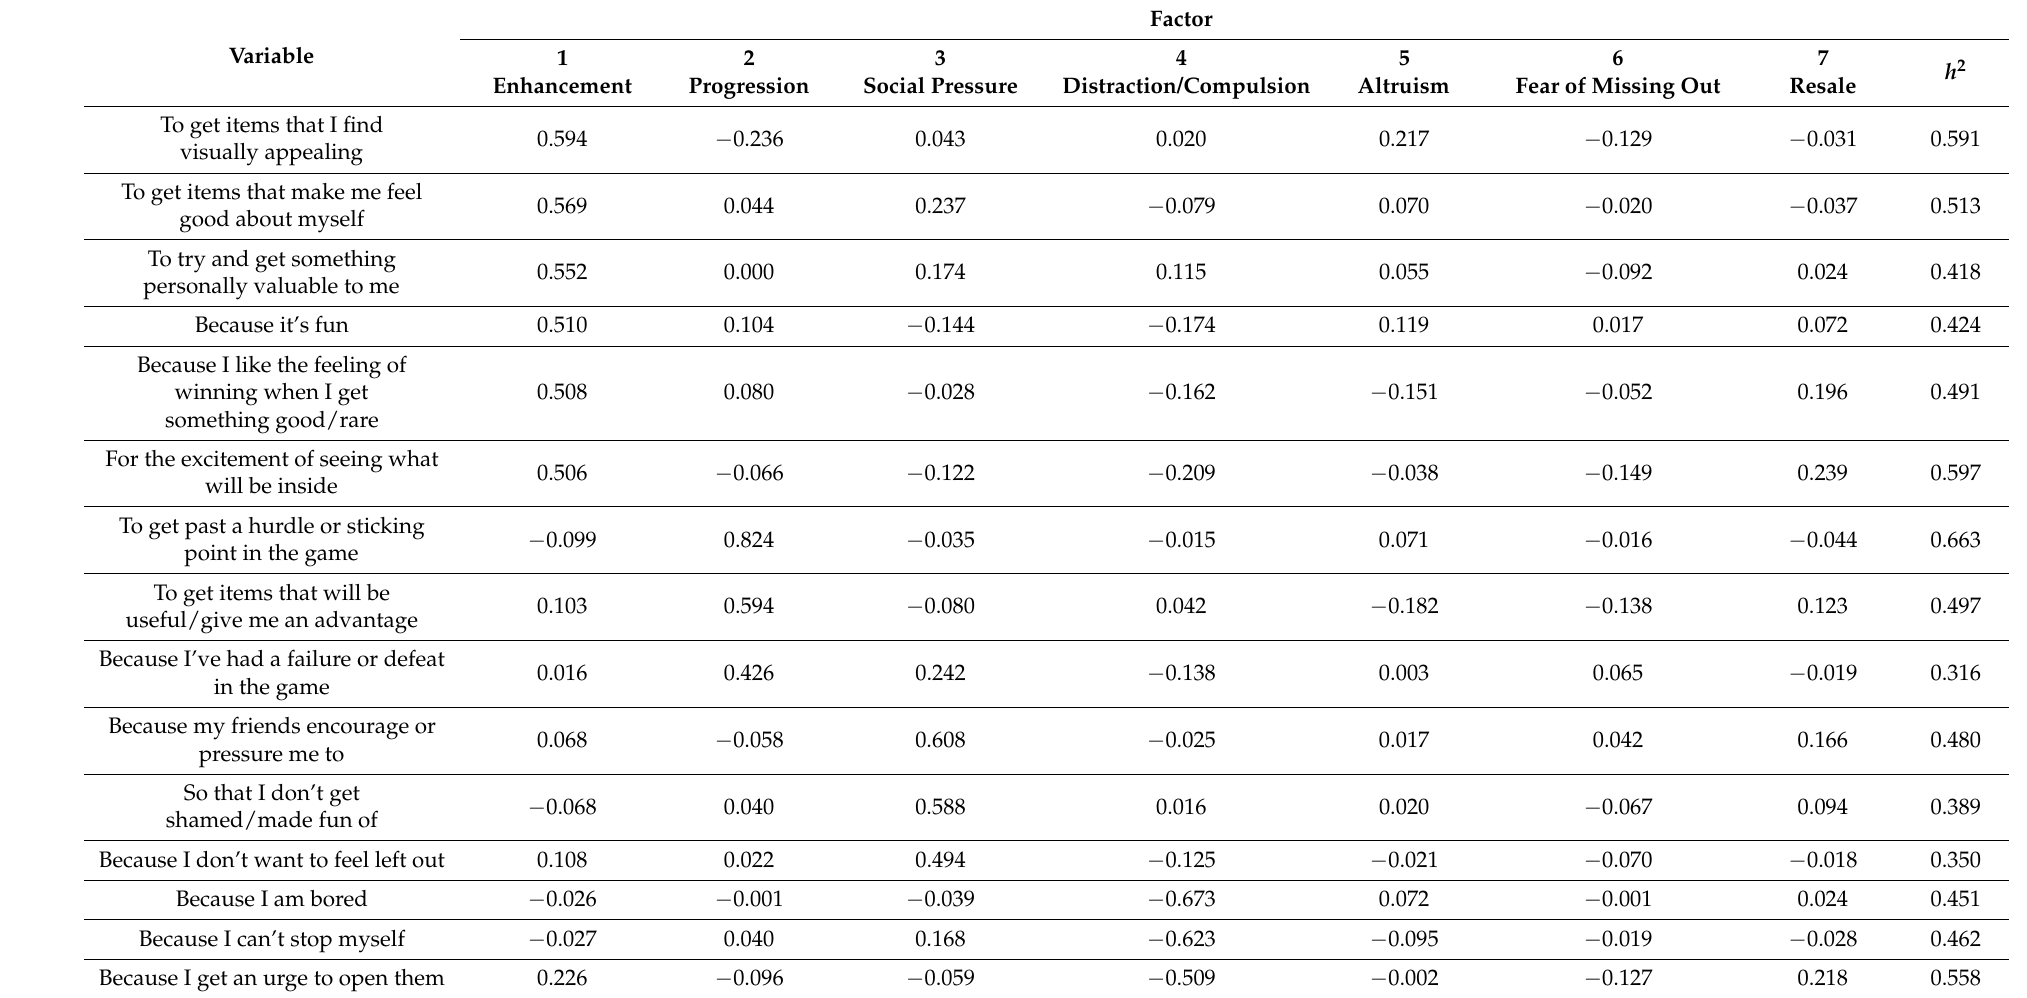
Table 3. Motivation Factor Pattern Matrix (rotated to the direct oblimin